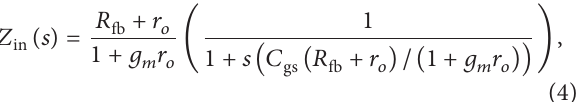
thermal noise coefficient. From (1) and (3), it can be observed that there is a close relationship between input impedance matching and NF. The NF can be significantly improved by increasing the RF input transconductance and the value of at the expense of the input impedance matching resistor 𝑅 fb